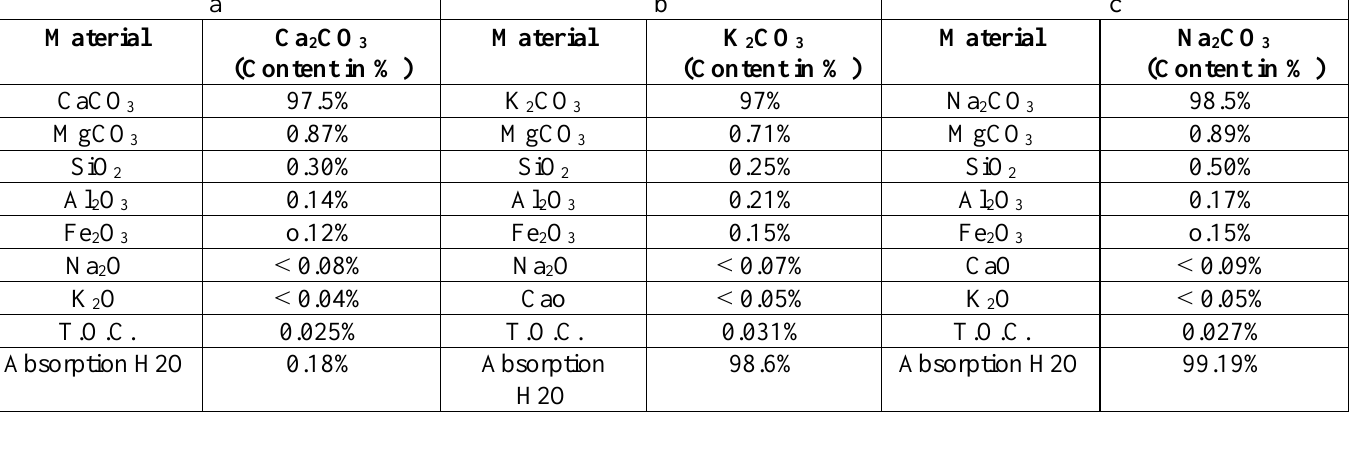
CO , (c) chemical 2 3